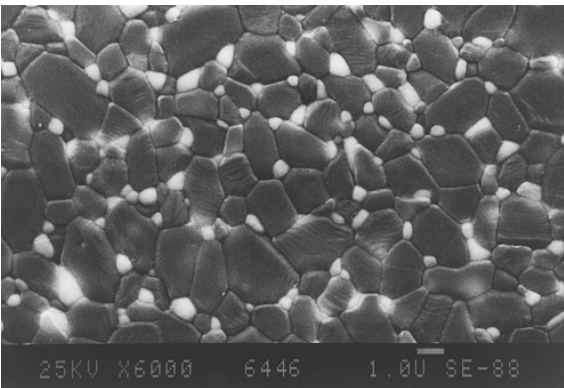
Figure 26. Microstructure of ZTA-ceramics containing 10 wt-% of ZrO 2 .